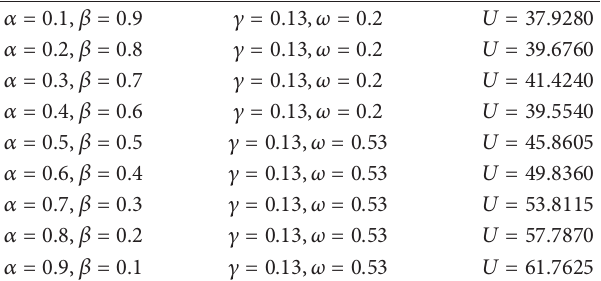
Table 2: The maximum weight gain system-wide assignment in different